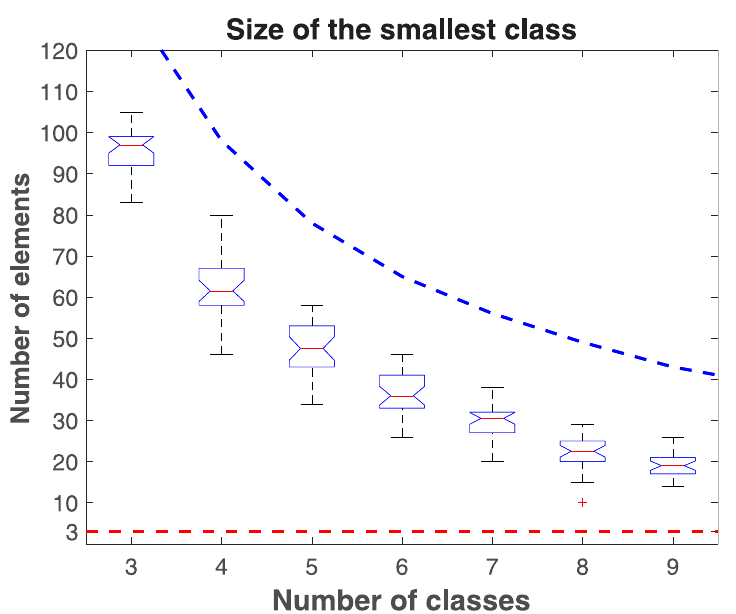
Fig 3. Boxplot of the size of the smallest class (given a designated number of classes) across 30 trials of 1000 repetitions, with α = 0.5. The theoretical upper bound for each experiment is the number of nodes that would appear in each class if all classes were the same size. The minimum class size was set at three. These results show that a minimum class size of three did not impinge on the optimization process.